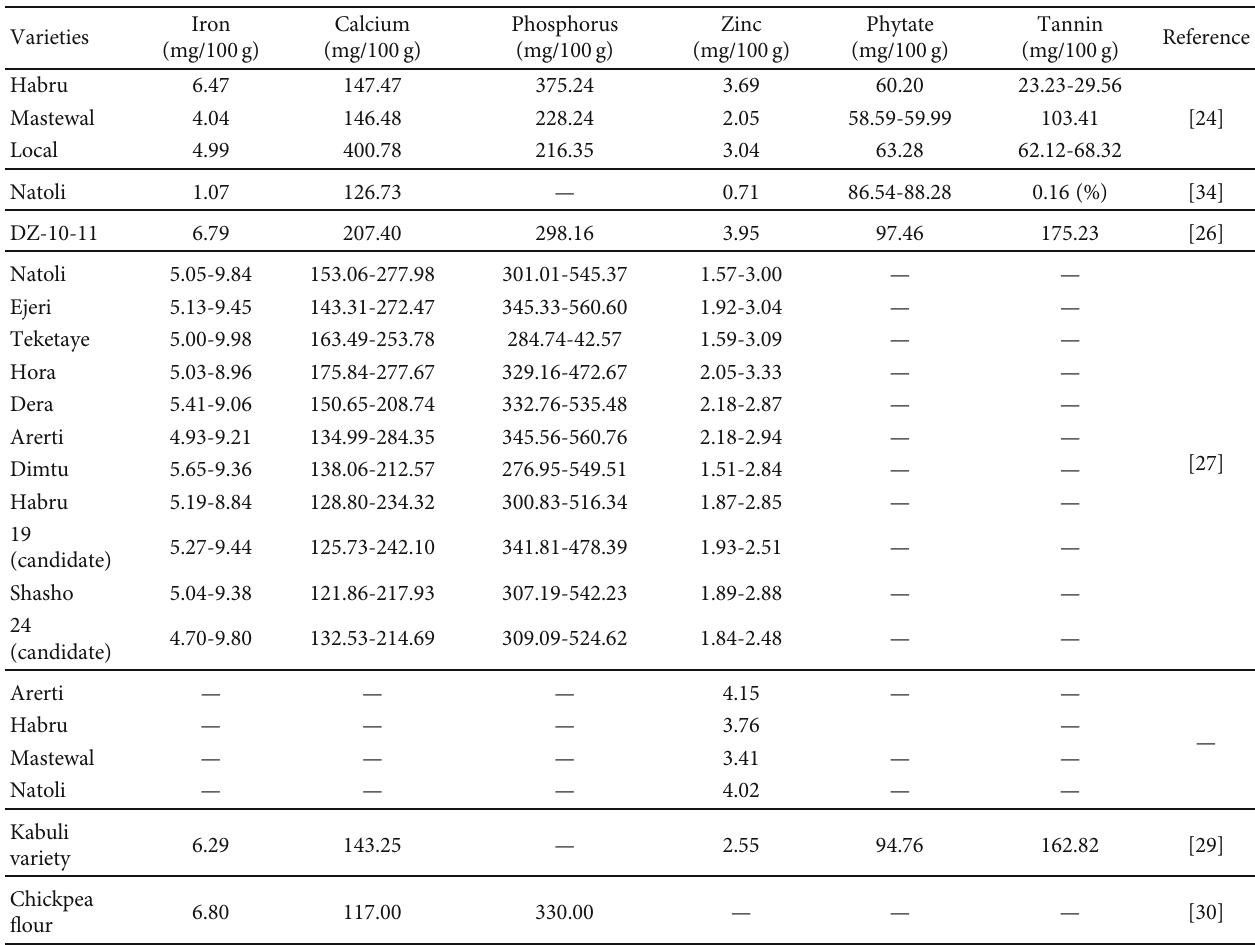
Table 4: Mineral and antinutritional contents of some of Ethiopian raw whole chickpea varieties.